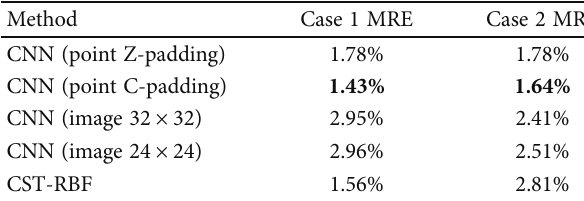
Figure 8: Feature maps of di ff erent convolutional layers. All these layers use circular padding. Table 2: Comparison of prediction